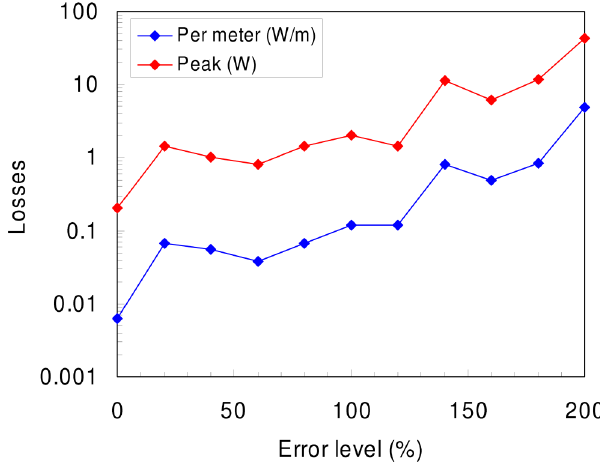
FIG. 8. (Color) The losses in the deuteron LEBT in respect to the error level.